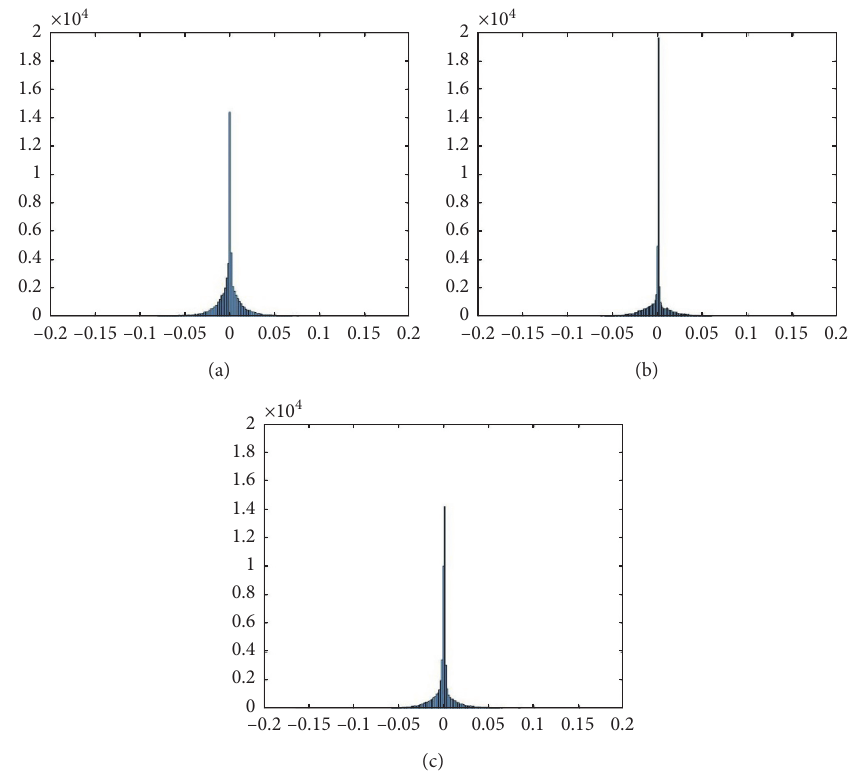
Figure 12: Histograms of source signals (three speech signals): (a) SA1 speech signal; (b) SA2 speech signal; (c) SI943 speech